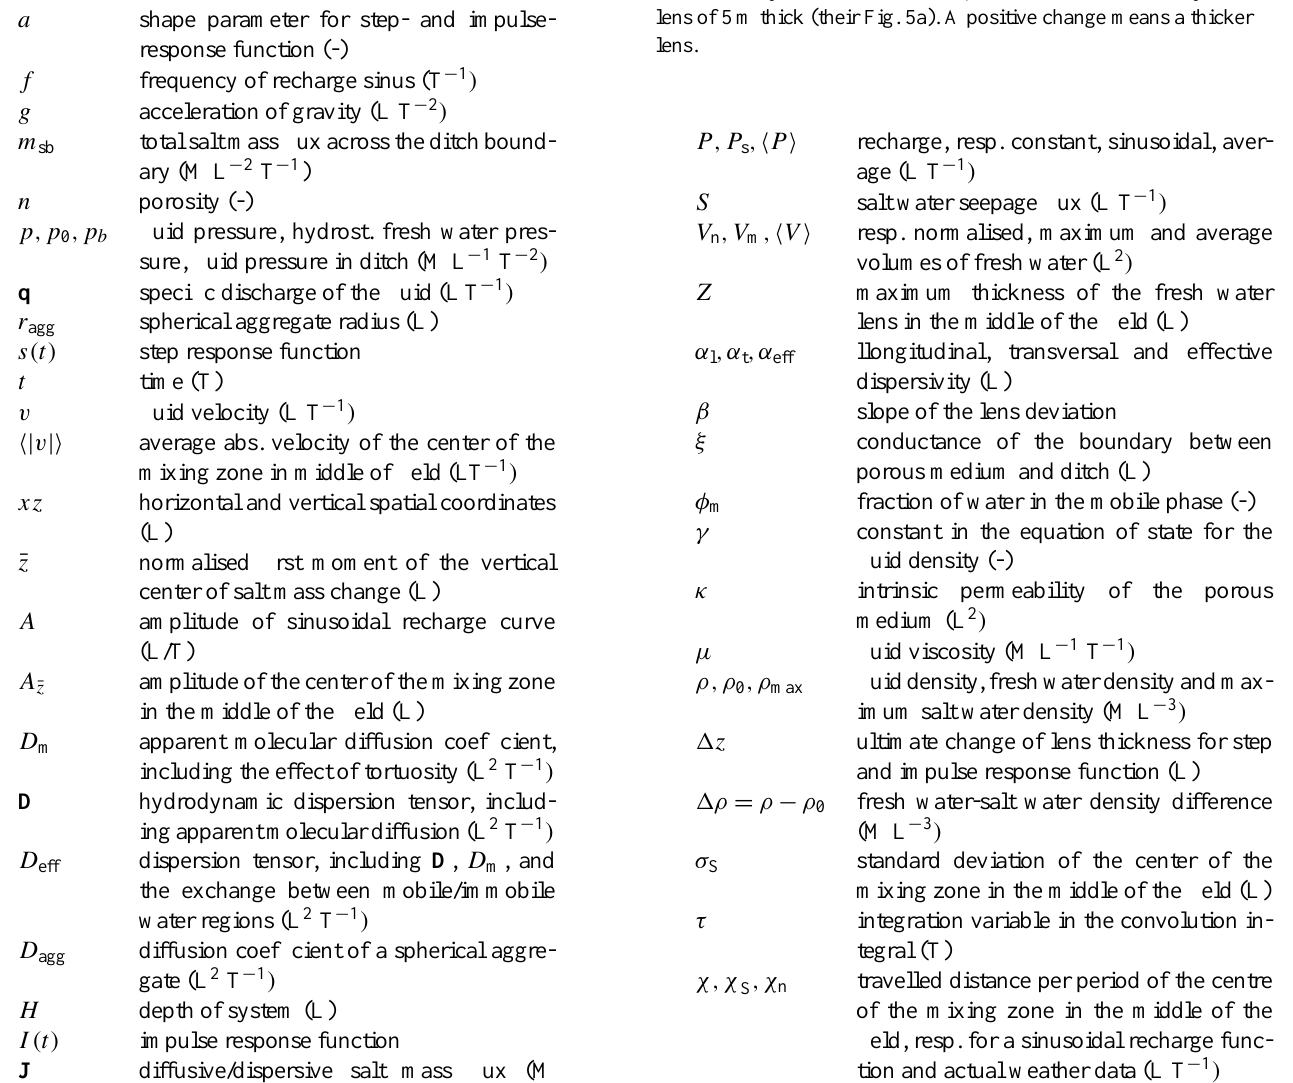
considered by Eeman et al. (2011), with reference to a steady state